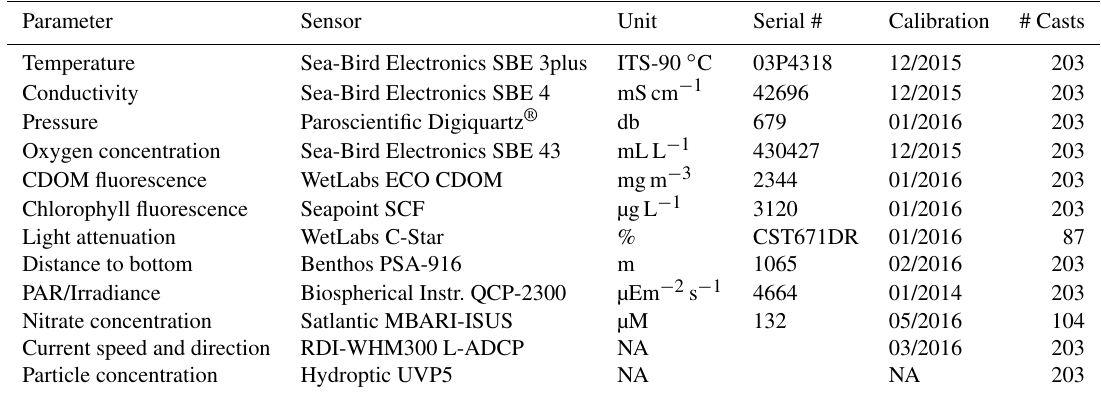
Table 2. List of the sensors attached to the rosette carousel. CDOM coloured dissolved organic matter; PAR photosynthetically available radiation; ADCP acoustic Doppler current profiler; UVP Underwater Vision Profiler. NA – not